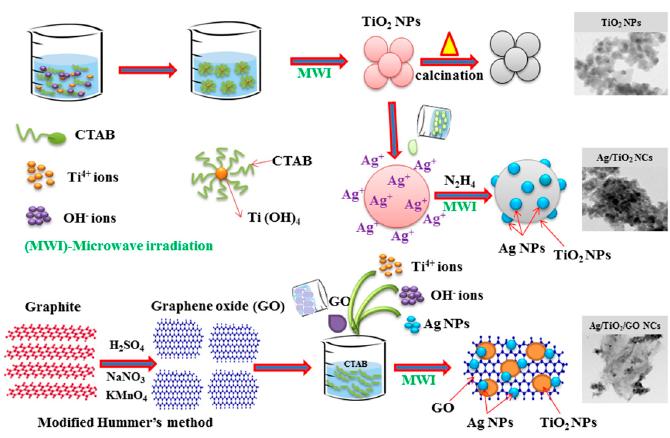
Figure 1. Schematic diagrams of the formation mechanism of TiO 2 , Ag/TiO 2 , and Ag/TiO 2 /GO nanocomposite synthesis by CTAB ‐ assisted sol ‐ gel and MWI techniques.